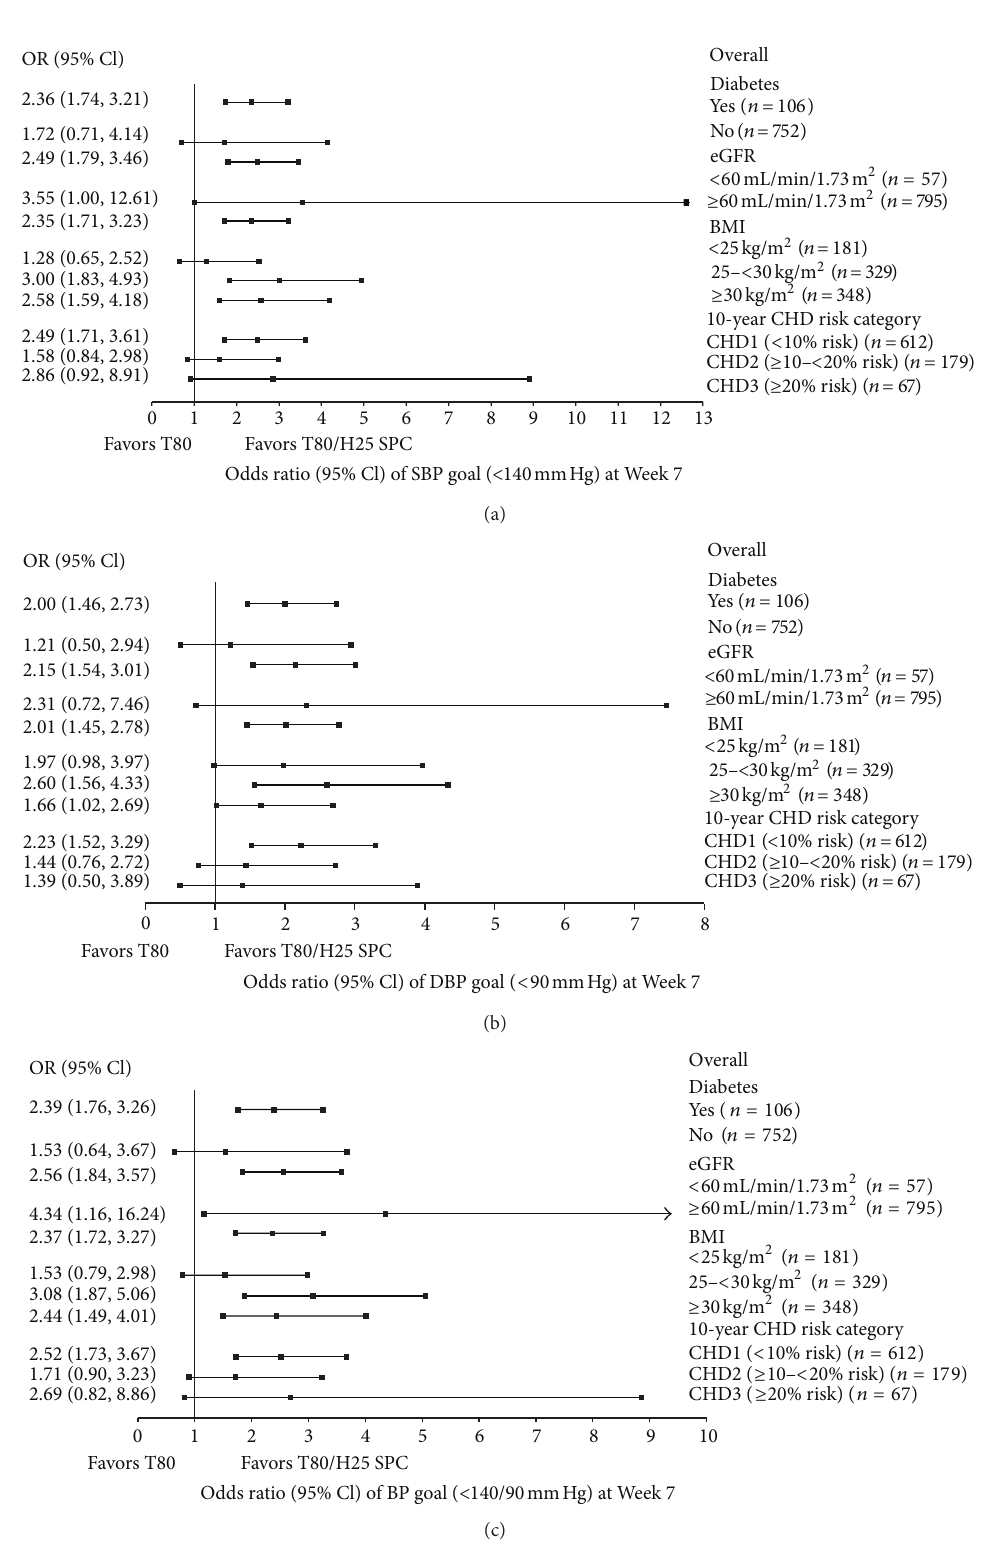
Figure 2: ORs (95% CI) of SPC T80/H25 versus T80 for BP goal rates. (a) SBP ( < 140mmHg), (b) DBP ( < 90mmHg), and (c) SBP/DBP goal ( < 140/90mmHg) at Week 7 by patient subgroup (FAS). BP: blood pressure; BMI: body mass index; CHD: coronary heart disease; CI: confidence interval; DBP: diastolic blood pressure; eGFR: estimated glomerular filtration rate; FAS: full analysis set; H25: hydrochlorothiazide 25 mg; OR: odds ratio; SBP: systolic blood pressure; SPC: single-pill combination; T80: telmisartan 80